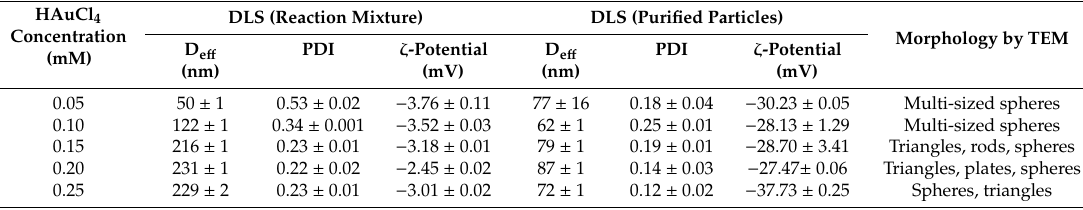
Table 1. E ff ect of HAuCl 4 concentration on the characteristics of the GNP 1 .